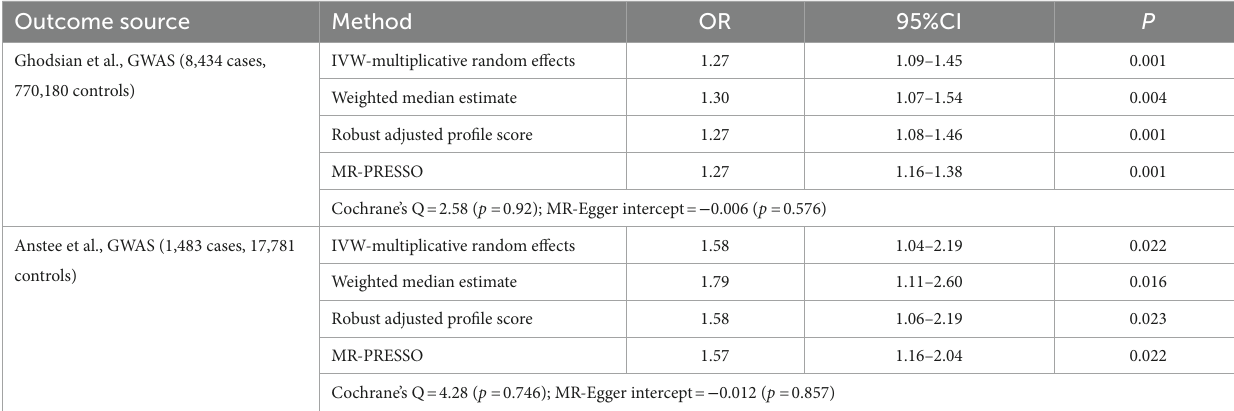
TABLE 1 Association of genetic prediction of serum vitamin B12 levels with non-alcoholic fatty liver disease in sensitivity analyses. Outcome